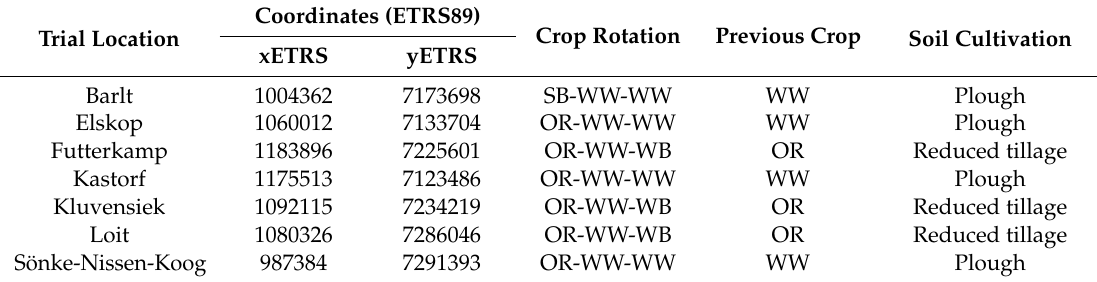
Table 1. Coordinates and agronomic practices (crop rotation, previous crop, soil cultivation) of the seven trial locations of the regional Fusarium monitoring in winter wheat in northern Germany from 2013 to 2017. Coordinate System: ETRS89 (European Terrestrial Reference System 1989). OR = Oilseed rape, SB = Sugar beet, WW = Winter wheat, WB = Winter